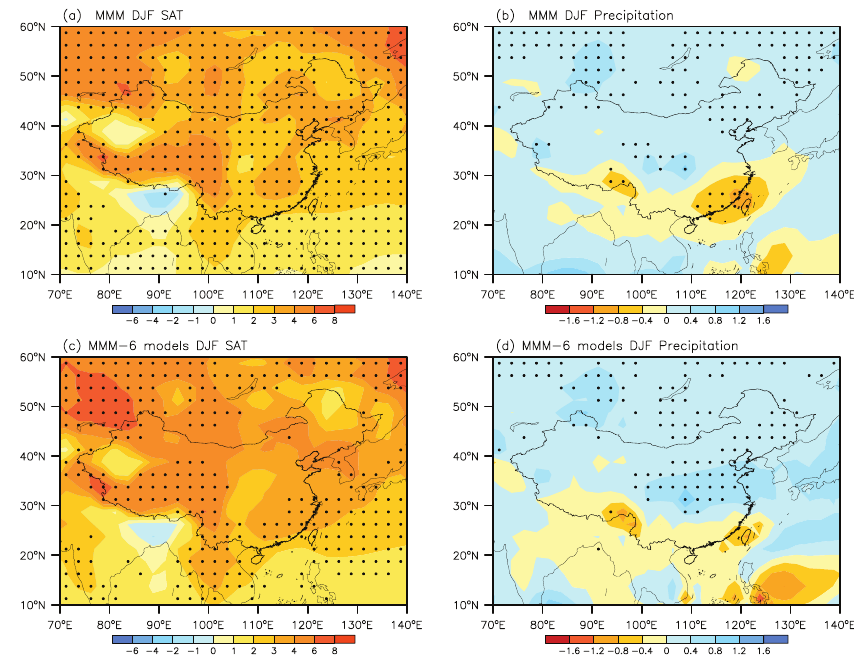
Fig. 8. Same as Fig. 6, but for winter SAT (left column, units: ◦ C) and precipitation differences (right column, units: mmday − 1 )